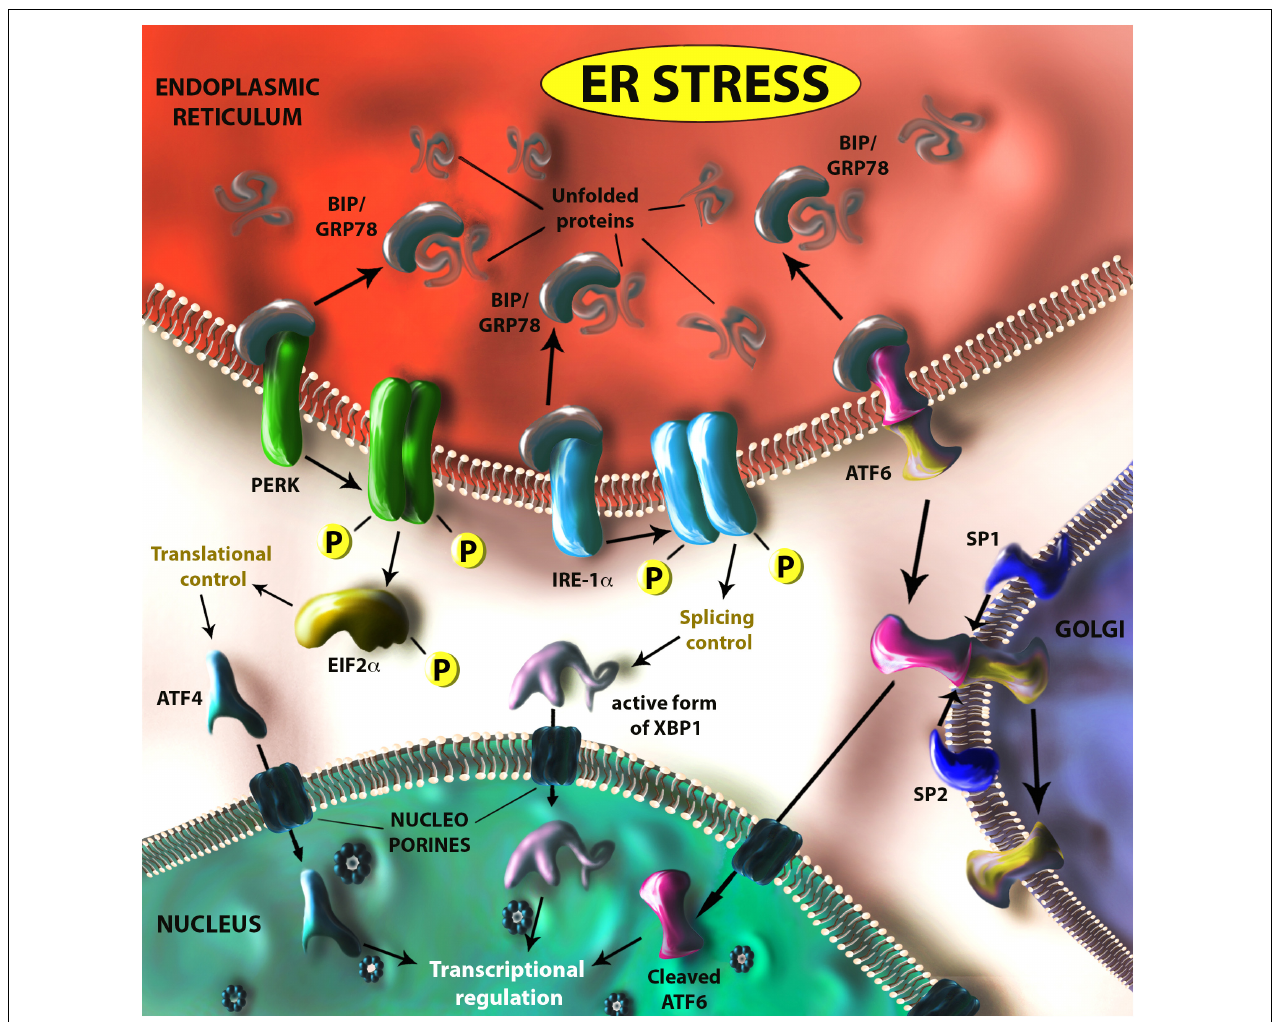
FIGURE 1 | Schematic representation of the unfolded protein response (UPR). In case of ER stress (due to viral infection, metabolic impairments, inflammation, cancer, hypoxia, etc.) translated proteins improperly folded are recognized by the endoplasmic reticulum (ER) chaperon GRP78. This protein is usually bound to three ER receptors (PERK, IRE-1 α , and ATF6), which are maintained in an inactive form. When GRP78 binds to unfolded proteins it releases these three receptors, which are activated either through dimerization and auto-phosphorilation (PERK and IRE-1 α ) or by translocation and cleavage (through SP1 and SP2 proteases) on Golgi apparatus membrane (ATF6). The PERK-controlled pathway is mainly deputed to the control of translational activity in the ER through EIF2 α phosphorilation, but has also an active role in transcriptional control by regulating ATF4 translation. IRE-1 α and ATF6, together with ATF4, have an important role in the transcriptional control of genes involved in UPR regulated processes such as apoptosis, autophagy, inflammation, and angiogenesis, etc. IRE-1 α regulates XBP1 activity by modulating its